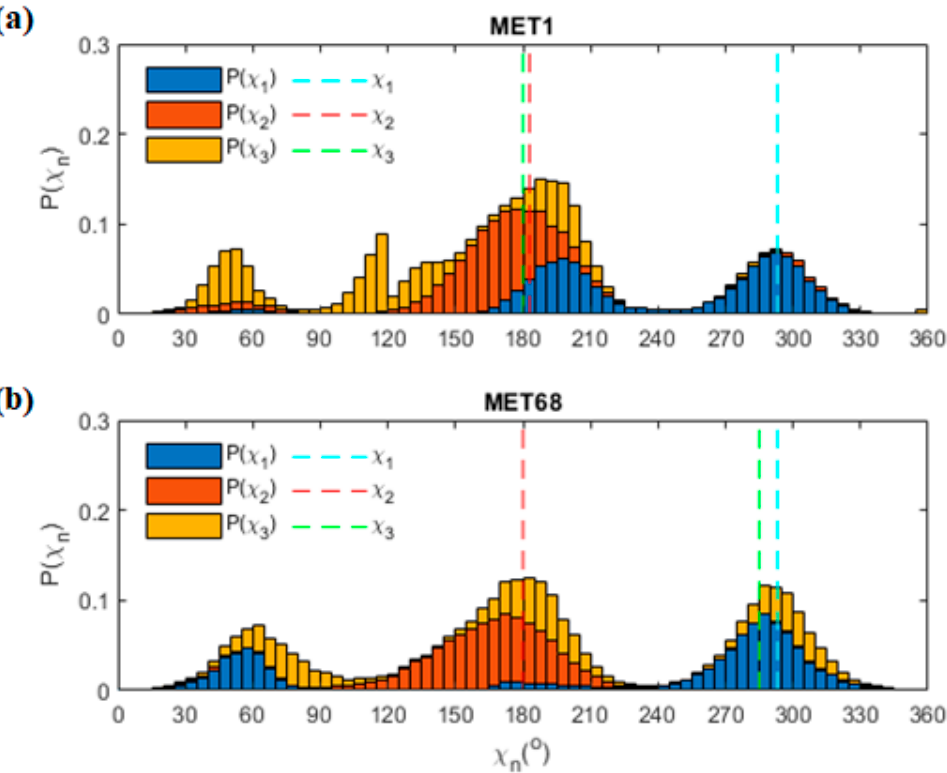
Figure 8. Stacked bar graph of side-chain χ 1 , χ 2 , χ 3 torsions probability distributions for Met1 ( a ), and Met68 ( b ). The probability values within 5 ◦ × 5 ◦ bins for separate torsion angles were marked as blue, orange, and yellow, respectively. Appropriate values of χ 1 , χ 2 , χ 3 angles from the experimental Hyp-1 model were presented sequentially as light blue, orange, and light green dashed lines.